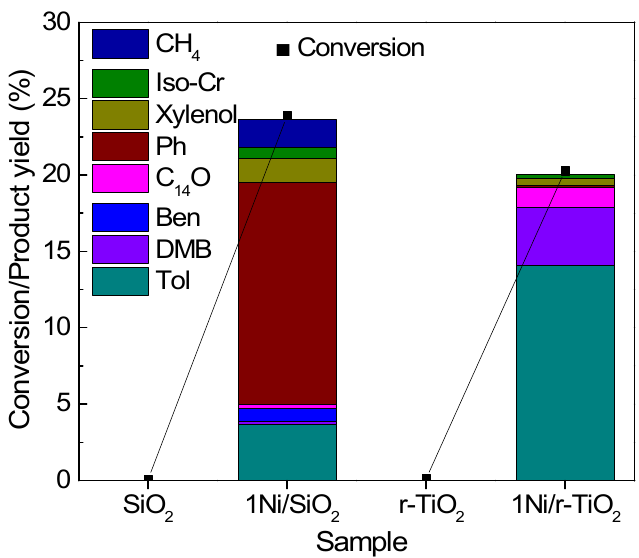
Figure 6. m-Cresol conversion and major product yields and on bare supports (SiO 2 [31] and r-TiO 2 ) and supported Ni catalysts (1Ni/SiO 2 and 1Ni/r-TiO 2 ). Reaction conditions: T = 350 °C, P = 1 atm, H 2 /m-cresol = 50, TOS = 30 min, W/F = 2 h. Product with a yield of less than 0.2% is not listed. Ben, Tol, Iso-Cr, Ph, DMB, and C 14 O represent benzene, toluene, cresol isomers, phenol, dimethylbiphenyl, and 5,5’-dimethyl-3-hydroxybiphenyl, respectively.